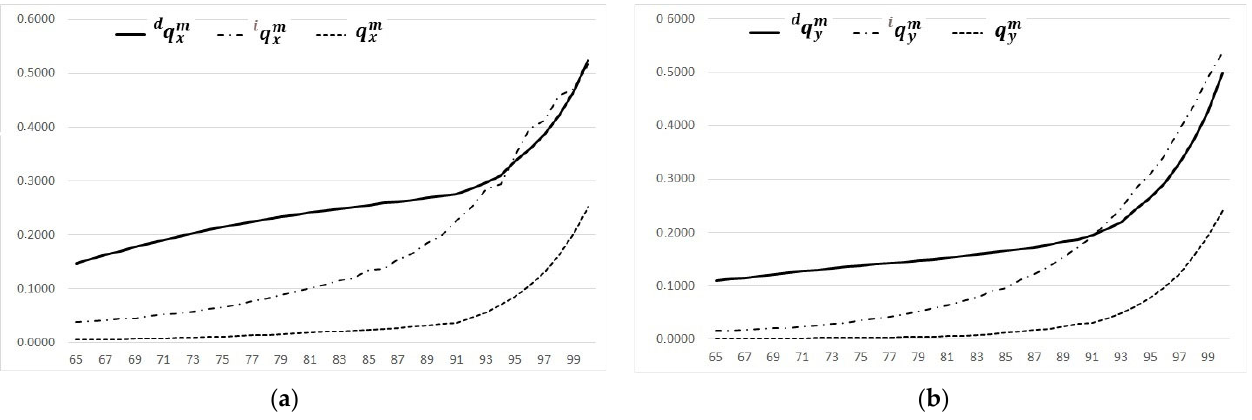
Figure 3. Mortality differential by status and gender after retirement age at 65. ( a ) Men; ( b ) women. Source: Own work. Database: PERM/F 2000 mortality tables for the general population [64]; Spanish social security actuarial tables for disability [65]; severe and high dependency mortality tables in Spain [71].